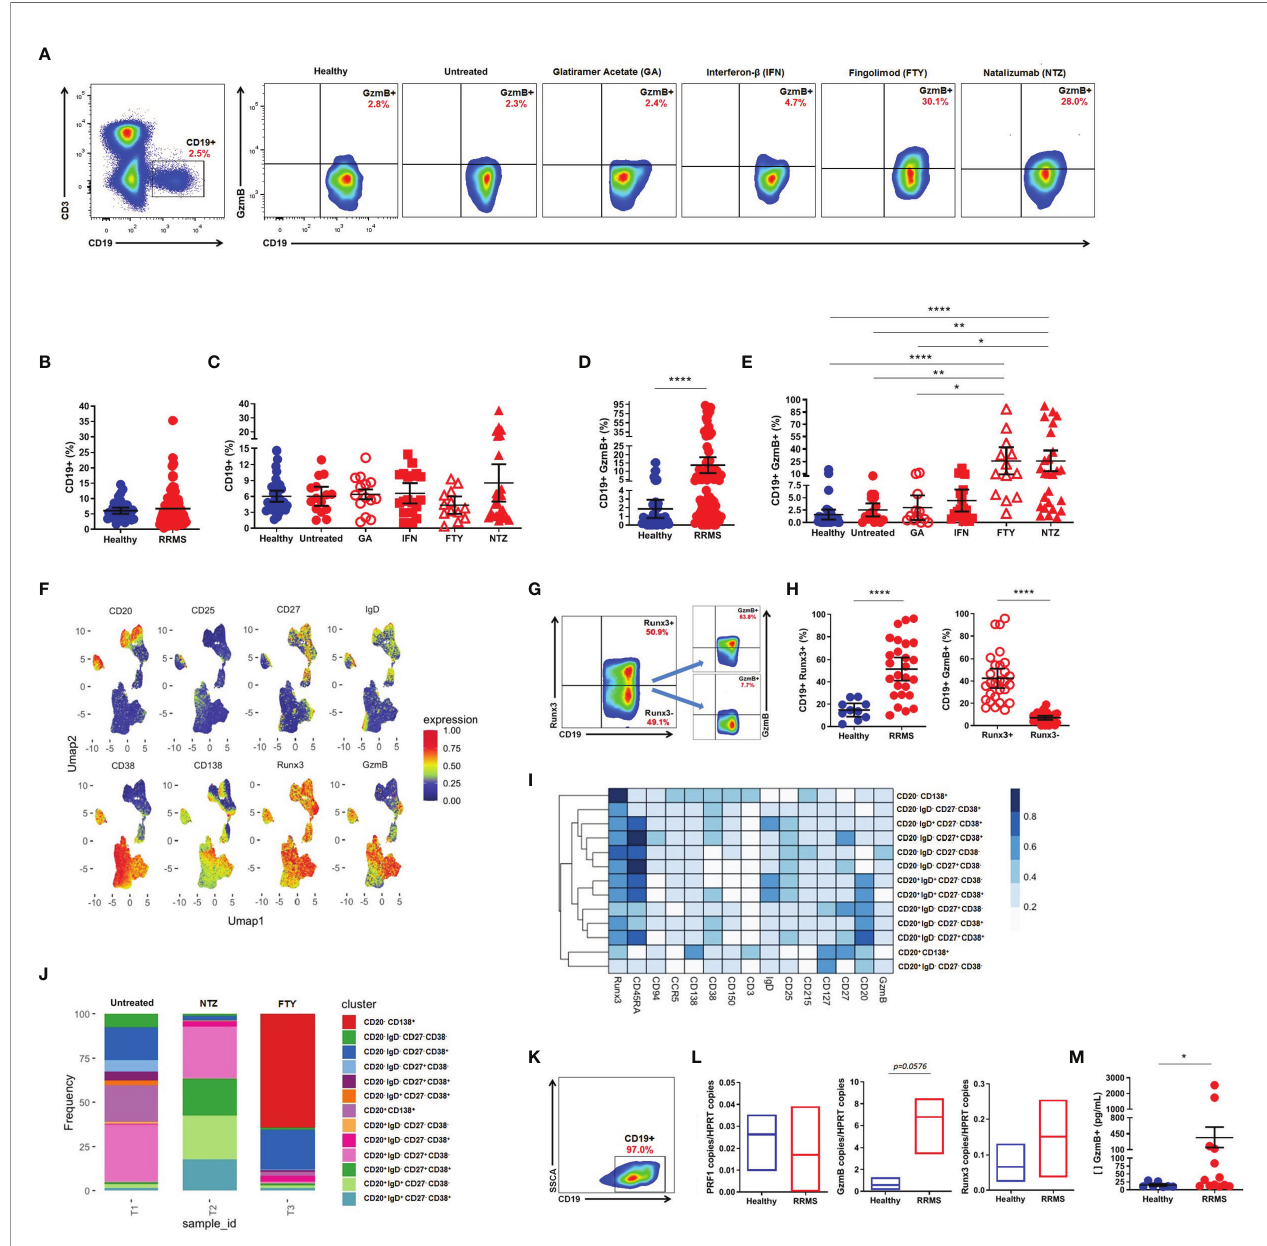
FIGURE 2 | Cytotoxic CD19 + B cells in relapsing-remitting multiple sclerosis (RRMS) patients. (A) Gate strategy for total CD19 + and CD19 + GzmB + B cells from healthy donors, untreated RRMS, and treated [Glatiramer Acetate (GA), Interferon- b (IFN), Fingolimod (FTY), and Natalizumab (NTZ)] RRMS patients. (B) Proportion (%) of total CD19 + B cells in healthy donors (blue) and RRMS patients (red). (C) Proportion (%) of total CD19 + B cells in healthy donors (blue), untreated RRMS (red), and treated RRMS patients (GA, IFN, FTY, NTZ) (red). (D) Proportion (%) of circulating CD19 + GzmB + B cells in healthy donors (blue) and RRMS patients (red). (E) Proportion (%) of circulating CD19 + GzmB + B cells in healthy donors (blue), untreated RRMS (red), and treated RRMS patients (GA, IFN, FTY, NTZ) (red). Bars represent mean values. Each column represents mean (95% CI). *p < 0.05; ** p < 0.01; **** p < 0.0001. (F) Uniform Manifold Approximation and Projection (UMAP) gated in CD3 - CD19 + B cells from RRMS patients with different conditions non-identi fi ed and based on the Arcsinh-transformed expression of the markers. (G) Gate strategy for granzyme B (GzmB)-derived CD19 + Runx3 + B cells. (H) Proportion (%) of GzmB-derived from circulating CD19 + Runx3 + vs. CD19 + Runx3 - B cells in healthy donors (blue) and RRMS patients (red). (I) Proportion (%) of GzmB derived from circulating CD19 + Runx3 + vs. CD19 + Runx3 - in RRMS patients (red). Each column represents mean (95% CI). *p < 0.05; ** p < 0.01; **** p < 0.0001. (I) Heatmap of the expression of the markers in subpopulations manually identi fi ed in CD3 - CD19 + B cells from RRMS patients. (J) Barplot representing the frequency of each subpopulation in CD3 - CD19 + B cells. (K) Gate strategy for isolated CD19 + B cells. (L) Quantitative PCR for PRF1 , GzmB , and Runx3 in isolated B cells from healthy donors (blue) and RRMS patients (red). (M) Concentration (pg/ml) of GzmB in supernatants of stimulated CD19 + B cells from healthy donors (blue) and RRMS patients (red). Each column represents mean (SEM). *p < 0.05; ** p < 0.01; *** p < 0.001; **** p <